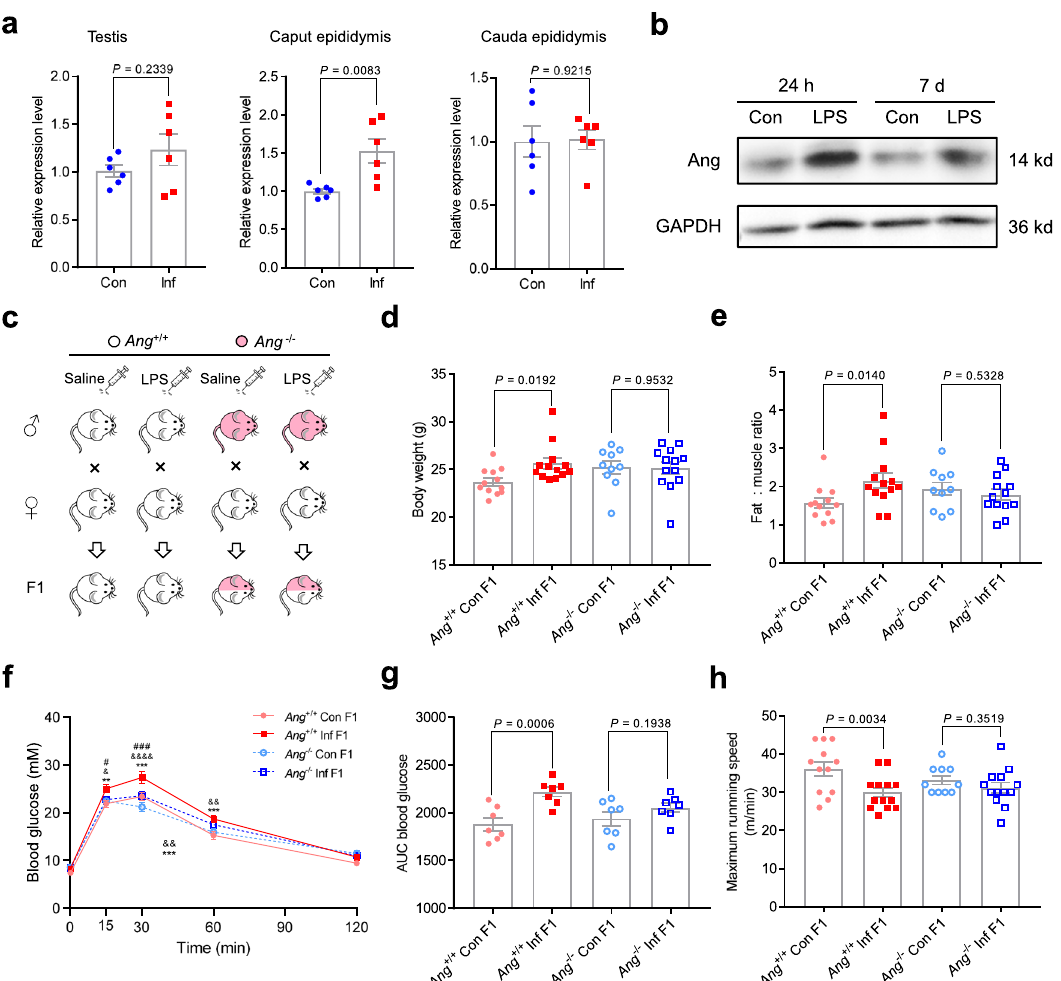
Fig. 2 Expression of Ang in in fl ammatory mice and metabolic parameters of F1 males from in fl ammatory and Ang -deleted mice. a The relative expression level of Ang mRNA in mouse testis, caput epididymis, and cauda epididymis under LPS (Inf) or saline (Con) treatment for 24 h. b Western blots of Ang protein in mouse caput epididymis under LPS or saline treatment for 24 h or 7 d. In ( a , b ), n = 6 mice per group. c The Ang + / + and Ang − / − F0 male mice were injected with LPS or saline once every other day for a total of four injections in 7 d in order to establish an in fl ammatory model. These mice were then allowed to mate with normal females for two days. Subsequently, offspring mice were exposed to chow diet and water ad libitum without any challenge throughout their lives. d Body weight of F1 males at 16 weeks of age. e Ratio of fat-to-muscle weight of F1 males at 16 weeks of age. f Blood glucose levels as assayed by GTT of F1 male mice at 14 weeks of age. ** P < 0.01, *** P < 0.001 ( Ang + / + Inf versus Ang + / + Con); & P < 0.05, && P < 0.01, &&&& P < 0.0001 ( Ang + / + Inf versus Ang − / − Con); # P < 0.05, ### P < 0.001 ( Ang + / + Inf versus Ang – / – Inf). g Area under the curve (AUC) statistics for ( f ). In ( f , g ), n = 7 mice per group. h Treadmill test results of F1 males at 8 weeks of age. In ( d , e ) and h , n = 12 in Ang + / + Con group, n = 13 in Ang + / + Inf group, n = 10 in Ang – / – Con group, and n = 13 in Ang – / – Inf group. Statistical analysis was performed by two-tailed unpaired Student ’ s t test ( a ), by two- tailed, one-way ANOVA ( d , e , g , h ) or two-way ANOVA ( f ), uncorrected Fisher ’ s LSD. Data are show as mean ± SEM. Source data are provided as a Source Data fi